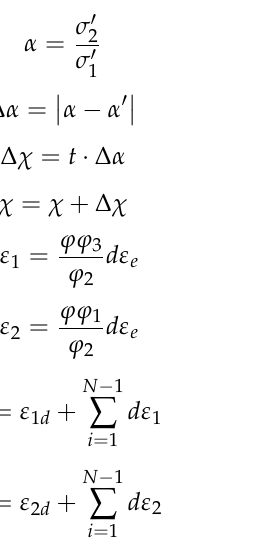
When d ε 2 is less than a certain value, the operation is stopped (this article specifies the truncation error d ε 2 ≤ 0.00001). The main strain value at this time is the ultimate strain value when the sheet material is localized necking: